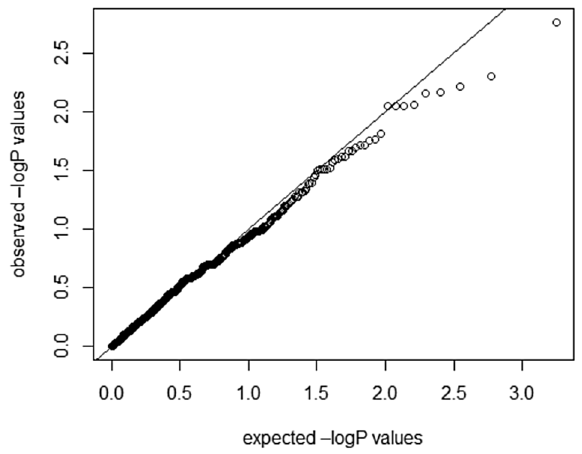
Figure 5. Quantile–quantile plots of the expected and observed − log( p -values) for the association of mitochondrial variants with obesity (λ = 1.0035) upon correction for age, sex and